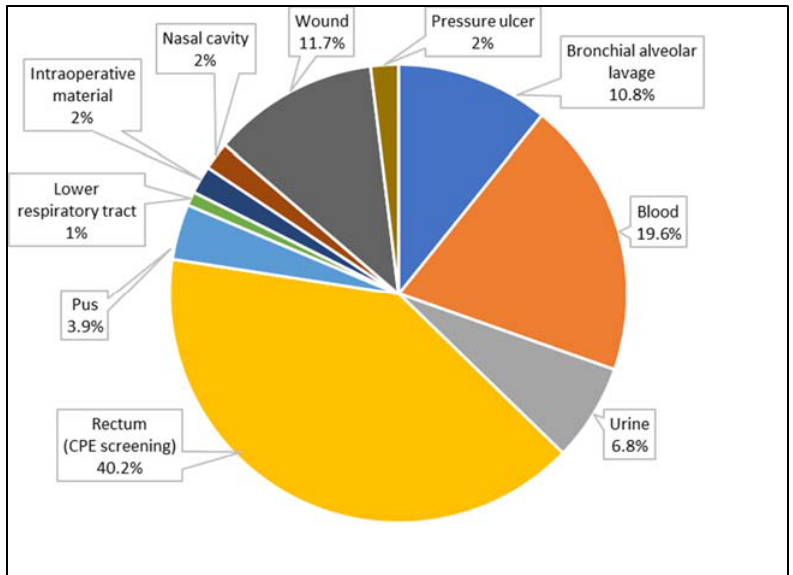
Figure 2. The percentage of biological materials from patients in hospitals in Lodz (Poland) taken under consideration in this study.